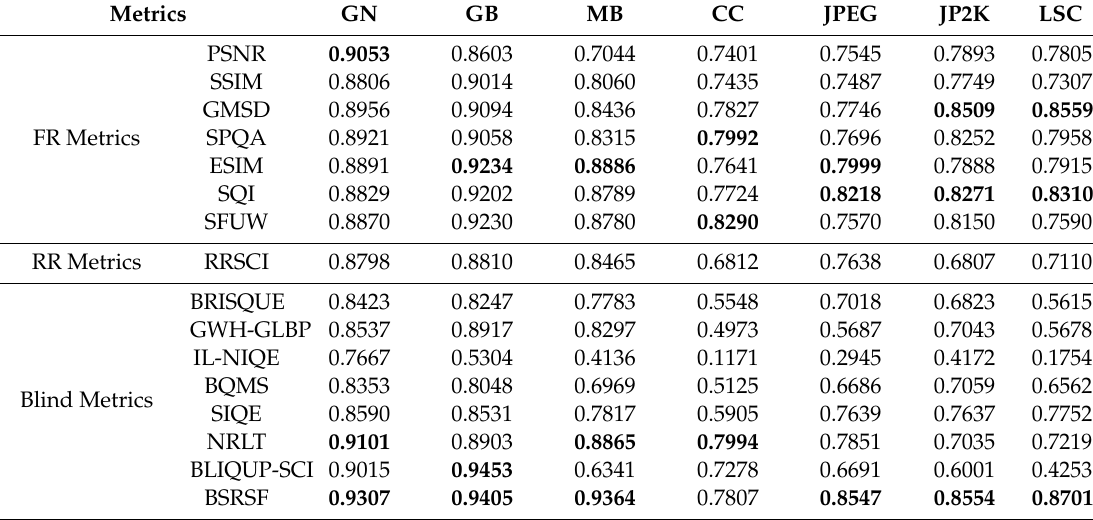
Table 3. PLCC scores of metrics for seven degradation types in